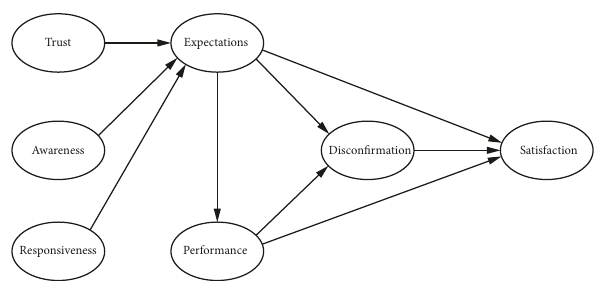
Figure 2: Expectancy disconfirmation model with antecedents of